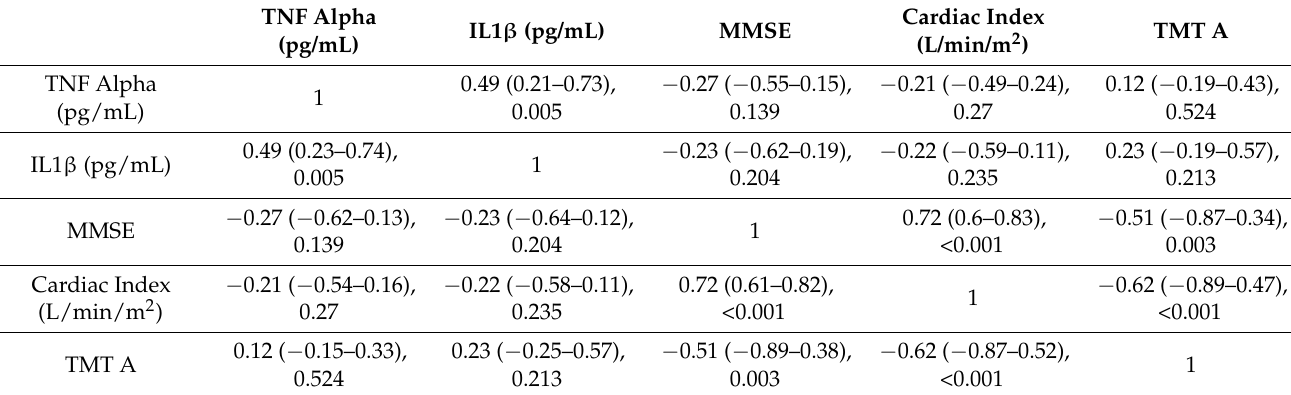
Table 3. Correlation analyses for cognitive function and inflammatory